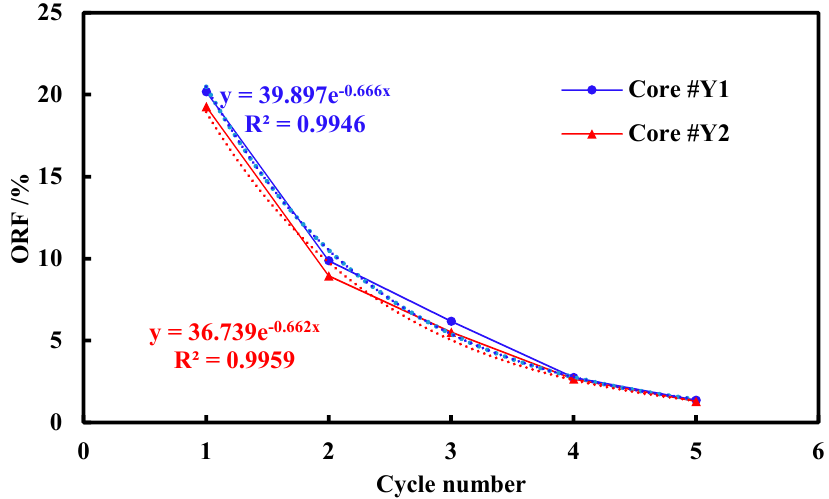
Figure 9. ORF of different CO 2 injection cycles.